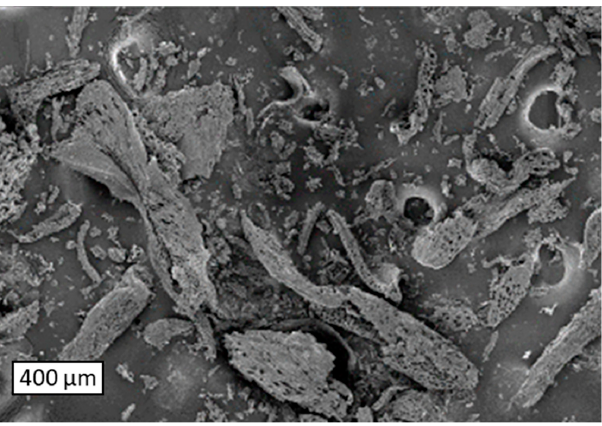
Energies 2023 , 16 , x FOR PEER REVIEW Figure 2. Powder ground with #0.5 rasp screen to a median size of 300 μ m. Magnitude 150×. Figure 2. Powder ground with #0.5 rasp screen to a median size of 300 µ m. Magnitude 150 × .